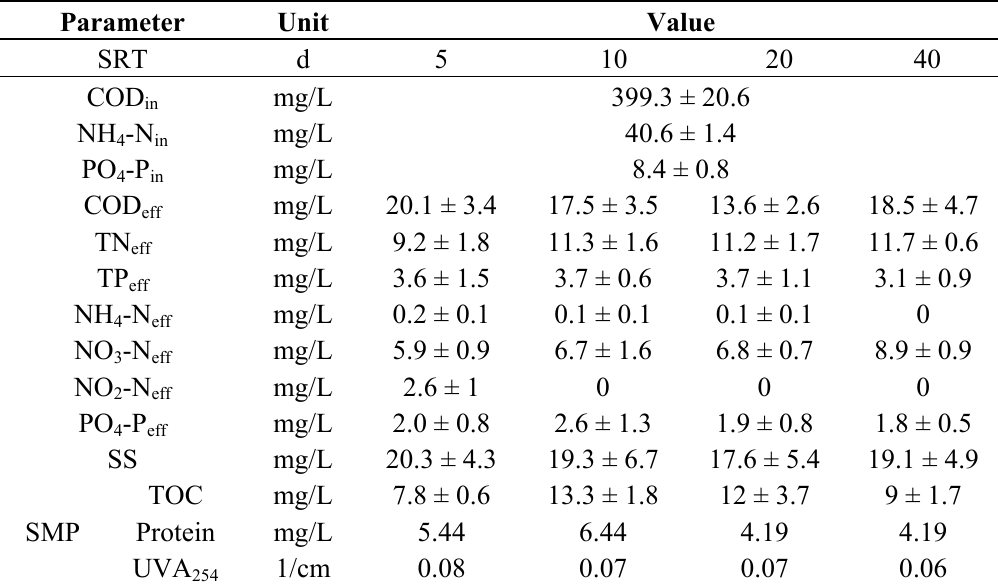
Table 1. Parameters of the influent and effluent of all SBRs at different SRTs.